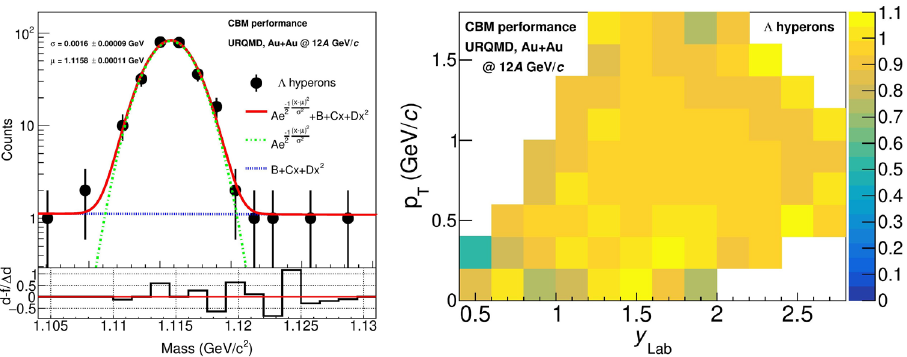
Figure 2. (left) Illustration of the procedure for Λ signal extraction after XGB selection is applied. Example is for 1 . 4 < p T < 1 . 6 GeV / c and 2 . 2 < y lab < 2 . 4 interval. The invariant mass yield (black circles) is fitted with the signal (Gaussian, green dotted line) and background (second order polynomial, blue line) shapes. (right) The p T - y lab distribution for the ratio of the fully corrected yield extracted after XGB selection to the simulated